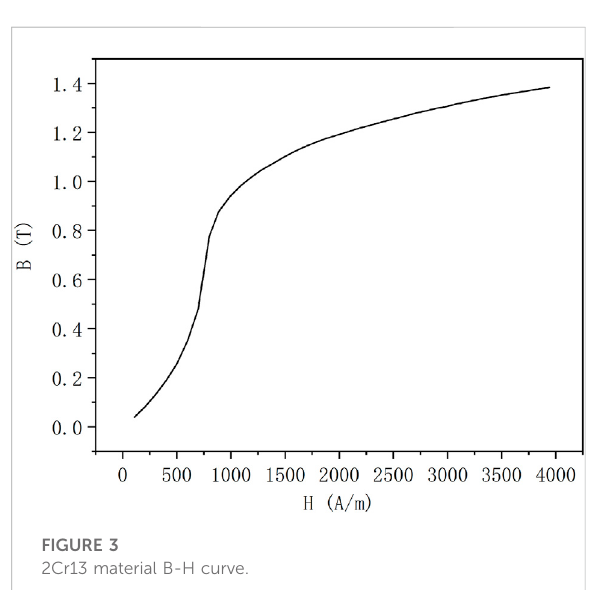
FIGURE 3 2Cr13 material B-H